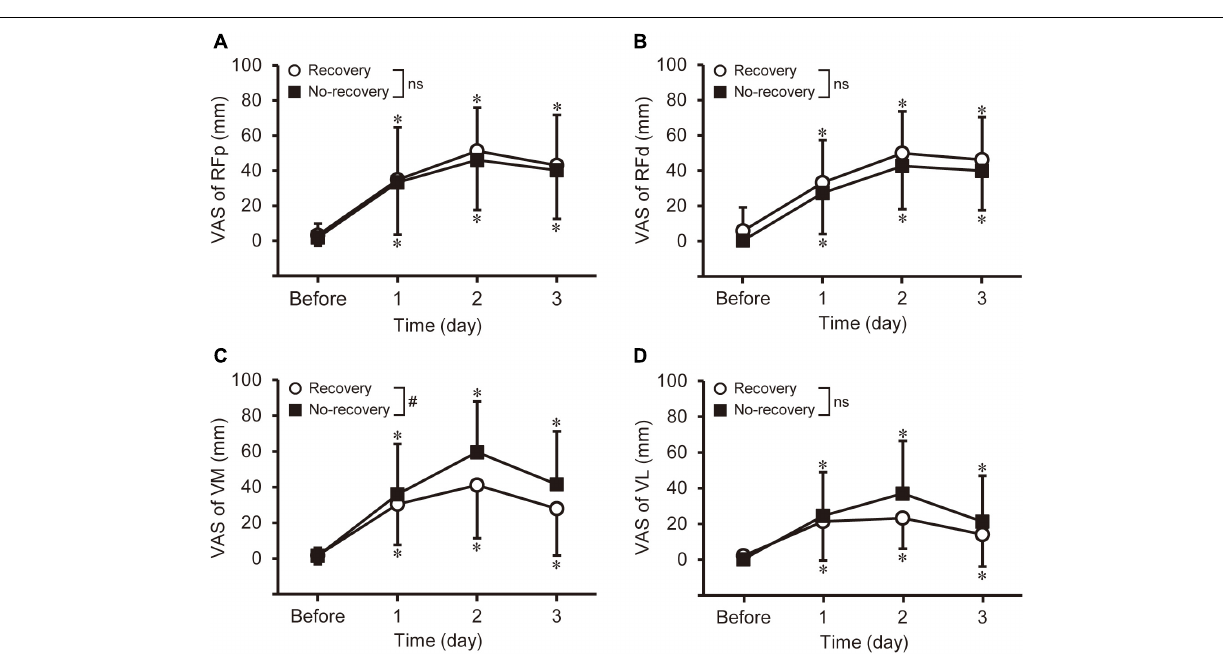
FIGURE 2 | Changes in muscle soreness of the rectus femoris in the proximal and distal regions (RFp: A and RFd: B ), vastus medialis (VM: C ), and vastus lateralis (VL: D ) assessed by a 100-mm visual analog scale (VAS) before and 1–3 days after eccentric exercise for the recovery and no-recovery groups. * Shows a significant difference from baseline. # Indicates a significant interaction effect. ns shows no significant interaction